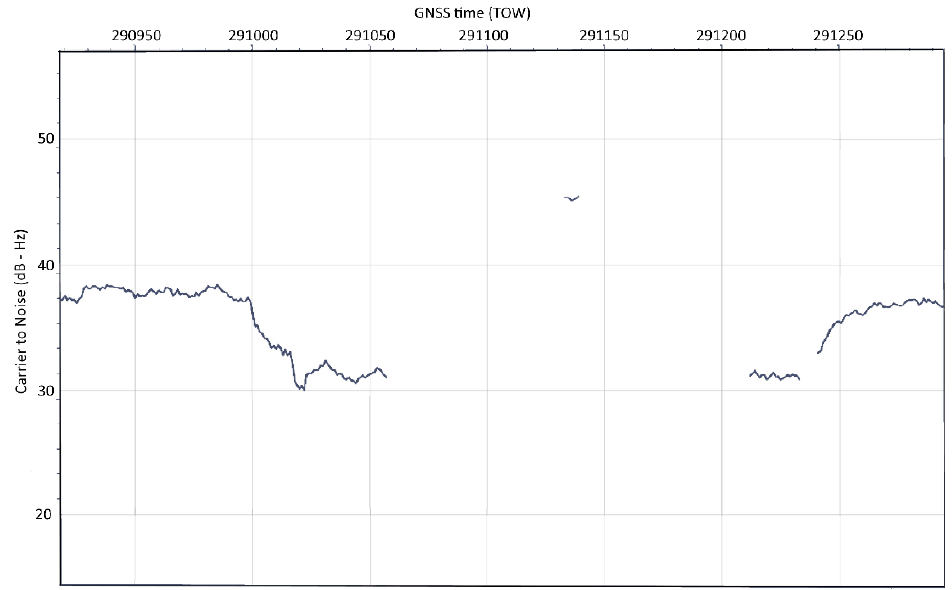
Figure 11. C/N 0 of the spoofed PRN18 tracked between Time-of-Week (TOW) 291,133 and 291,139.